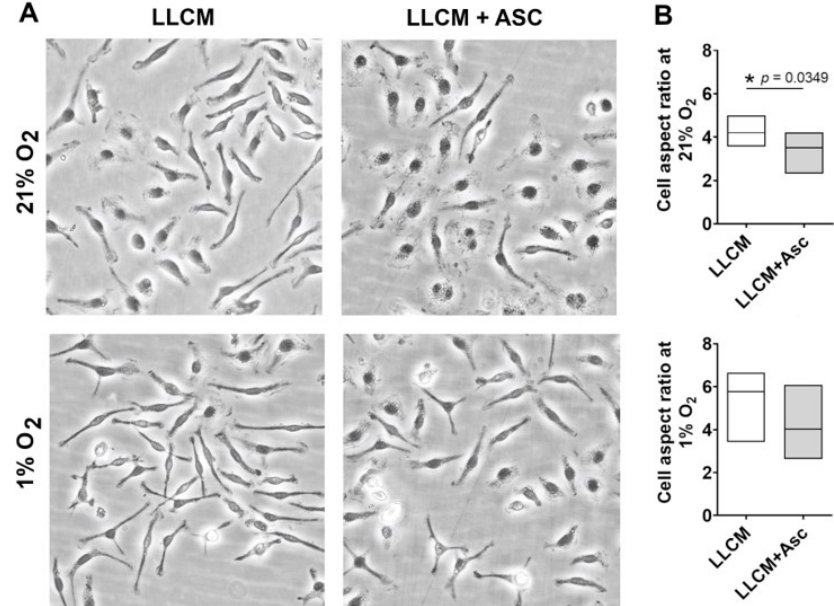
began to plateau at about 8 h at ~ 8 nmol/million cells. Graphs represent data obtained from 3 independent experiments (mean ± SD). Note that, where not visible, error bars fall within the symbols.